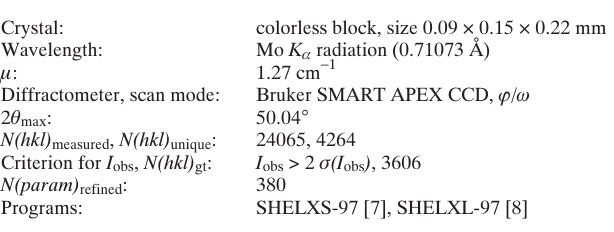
Table 1. Data collection and